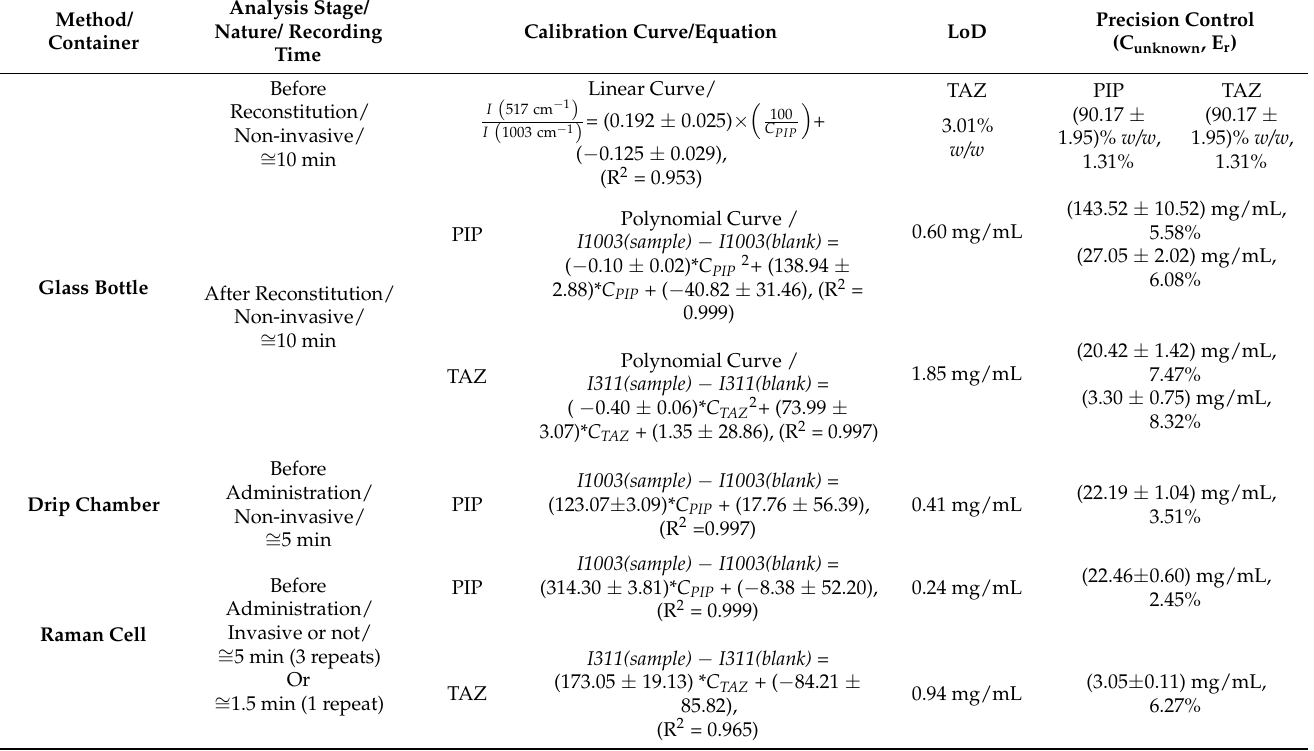
Table 9. Stage and nature of analysis, the measurement recording time, the respective calibration curve/equation, LOD, and precision control results, regarding the analytical alternatives–methodologies suggested here, i.e, measurement through the commercial glass bottle, the drip chamber part of the IV set, or a Raman optic